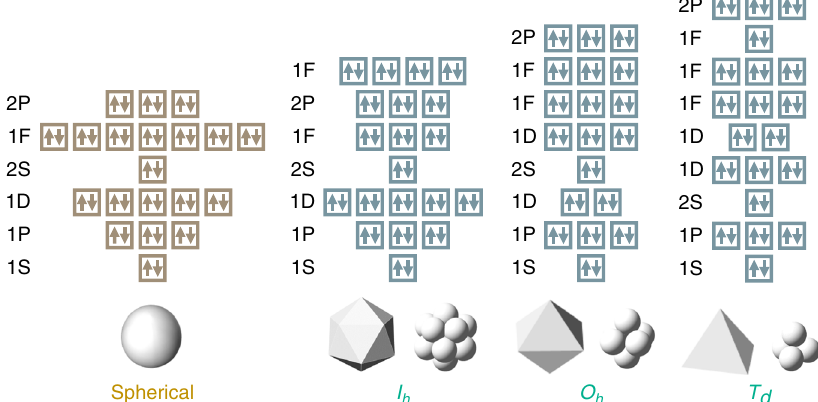
Fig. 1 Electronic con fi gurations based on the symmetry-adapted orbital (SAO) models. The order of the orbital levels generally obeys this rule, although many valence electron systems have strong interelectronic interactions and distorted structures, often changing the order of orbital levels partially